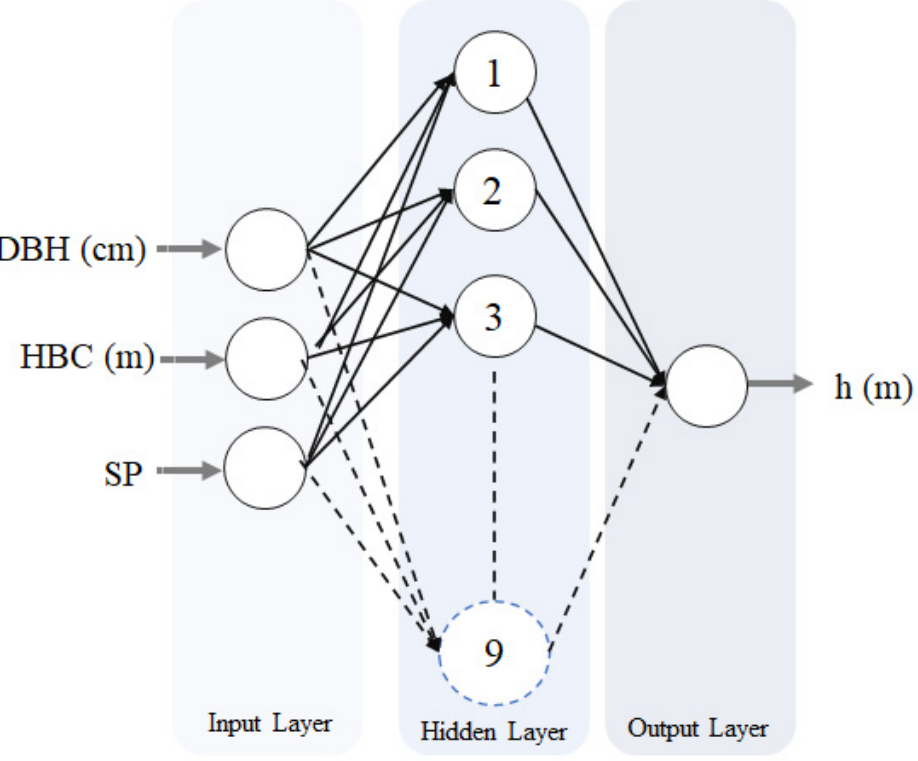
Figure 3. Architecture of Artificial Neural Networks (ANNs) used in training for the prediction of height for Brazilian pine.